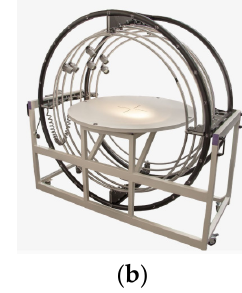
Figure 6. ( a ) Heliodon built by Lopez in 2016, ( b ) Sun Emulator Heliodon.